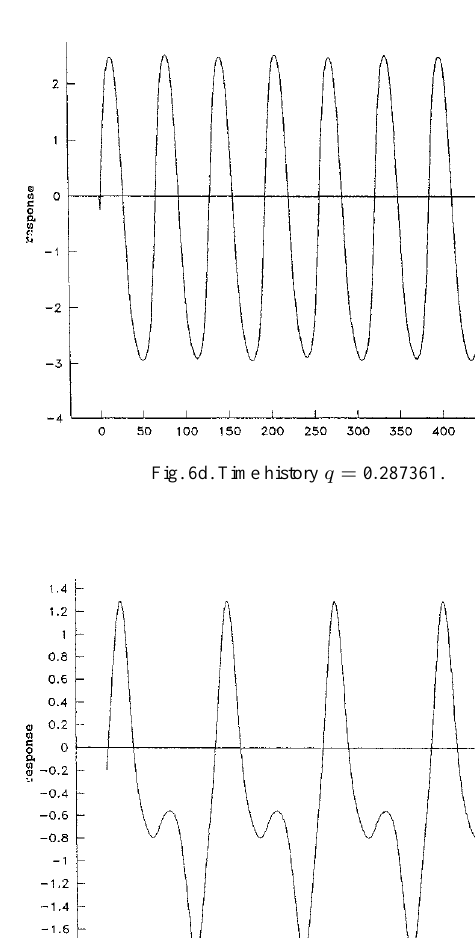
Fig. 5g. Phase diagram q = 0 : 600587.